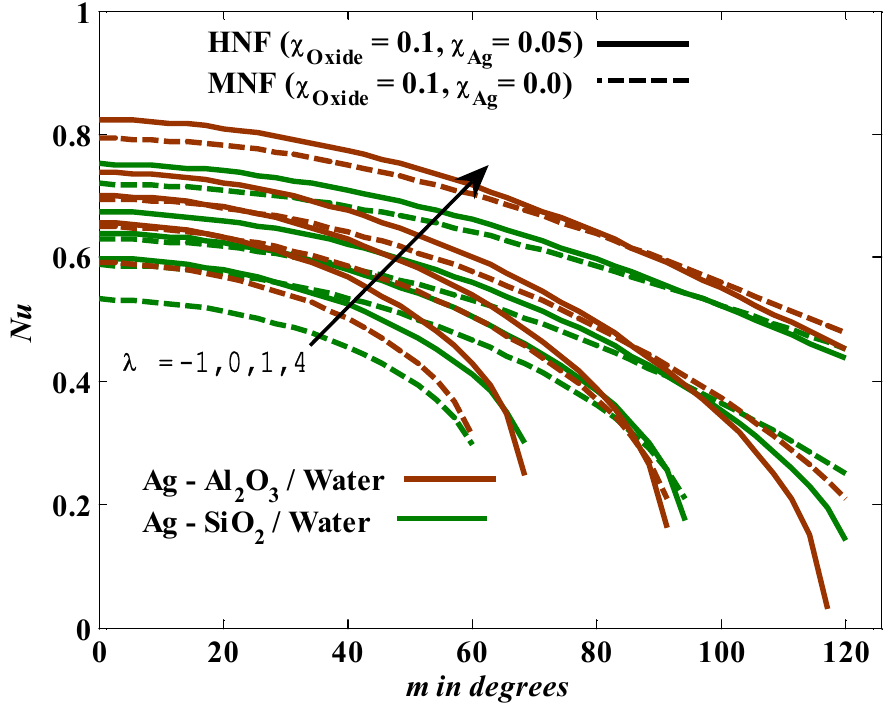
80 Figure 6. Illustration of λ versus Nusselt number at fixed values of We = 0.2, R = 0.1, & M = Figure 6. Illustration of  versus Nusselt number at fixed values of Figure 6. Illustration of  versus Nusselt number at fixed values of